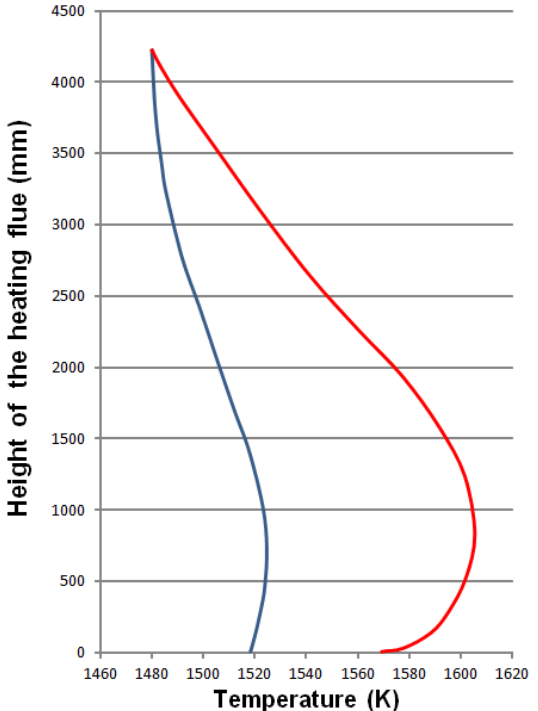
Figure 2. The diagram of an exemplary temperature distribution along the height of the PWR-63 battery heating flues. The red line shows the 15 th min of the combustion phase. The blue line shows the 17 th min of the combustion cut-off phase.